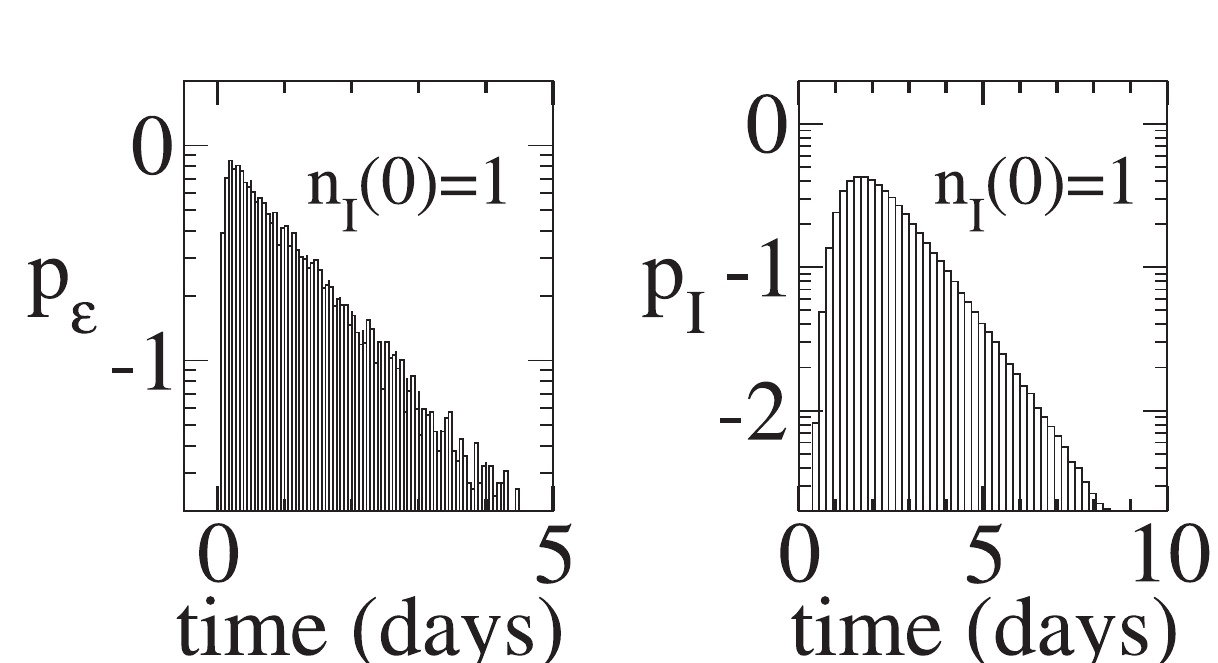
Figure 10. Burst model. Top Left: Conditional Distribution of times until an infection begun with a single virion goes extinct. The conditional mean time to extinction is about 0 : 04 days. Top Right: Distribution of times until an infection begun with a single virion results in 32 infected cells, given that the infection does not go extinct. The conditional mean time until there are 32 infected cells is 2 : 5 days. Bottom Left: Distribution of times until an infection begun with a single infected cell goes extinct. The conditional mean time to extinction is about 1 : 2 days. Bottom Right: Distribution of times until an infection begun with a single infected cell results in 32 infected cells, given that the infection does not go extinct. The conditional mean time until there are 32 infected cells is 2 : 46 days.